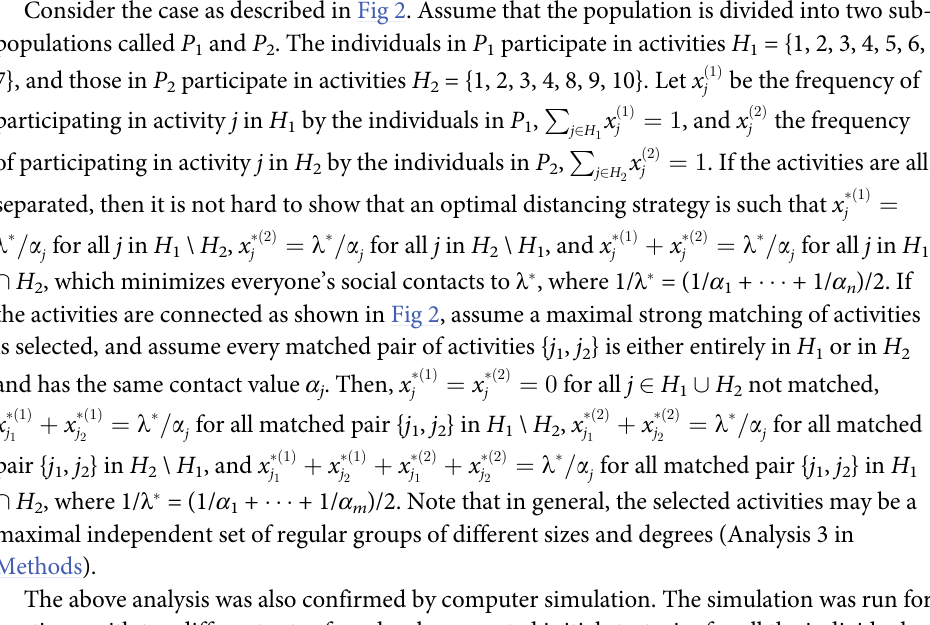
Table 2. Simulation results for the population in Fig 2 with two subpopulations P 1 and P 2 , each having a preferred subset of activities. Act Test 1